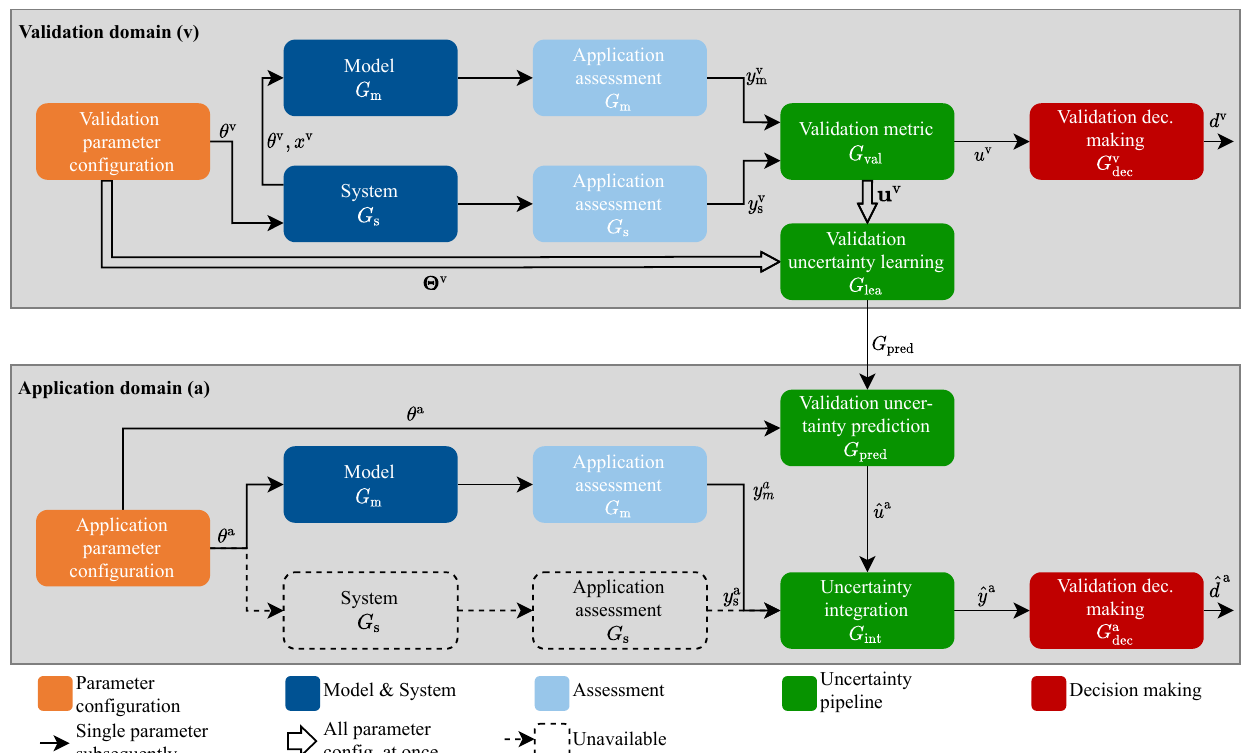
Figure 4. Statistical verification validation and uncertainty quantification framework for modular automotive vehicle simulations in large application domains using uncertainty learning. Adapted from Riedmaier et al. [30] with new